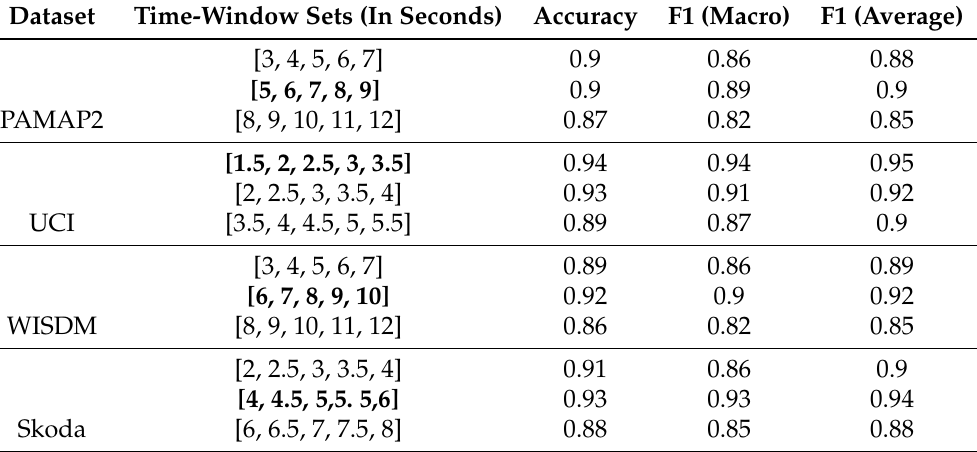
Table 5. HAR accuracy on different set of window sizes using DTE on the datasets using the